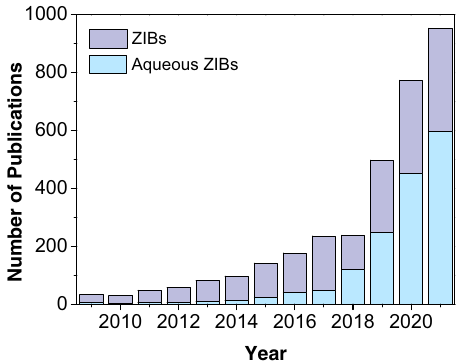
Fig. 1 Number of scienti fi c peer-reviewed publications on ZIBs. Total number of scienti fi c publications on ZIBs (organic- plus aqueous-based ZIBs) and speci fi cally on aqueous ZIBs published in recent years (Data collected in November 2021 from Clarivate Web of Science. Keywords used: “ zinc-ion batteries ” , “ aqueous zinc-ion batteries ”